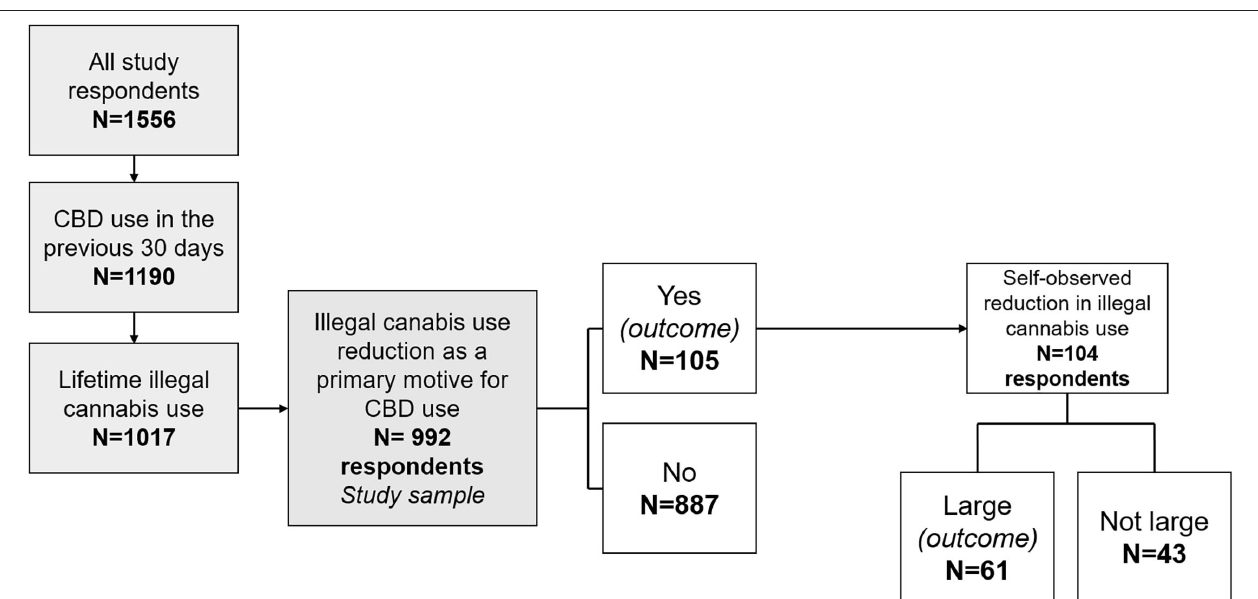
FIGURE 1 | Flow chart of the study, design of the regression outcomes, and distribution of participants according to the two study outcomes. CBD,